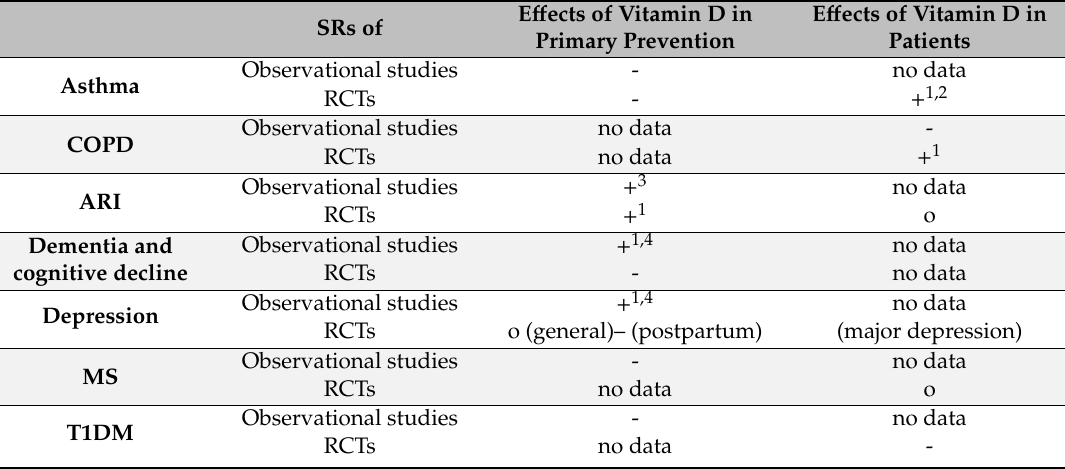
Table 2. Summarised results of the included SRs on vitamin D and the seven selected extraskeletal diseases. (ARI, acute respiratory tract infections; COPD, chronic obstructive pulmonary disease; MS, multiple sclerosis; RCTs, randomised controlled trials; SRs, systematic reviews; T1DM, type 1 diabetes